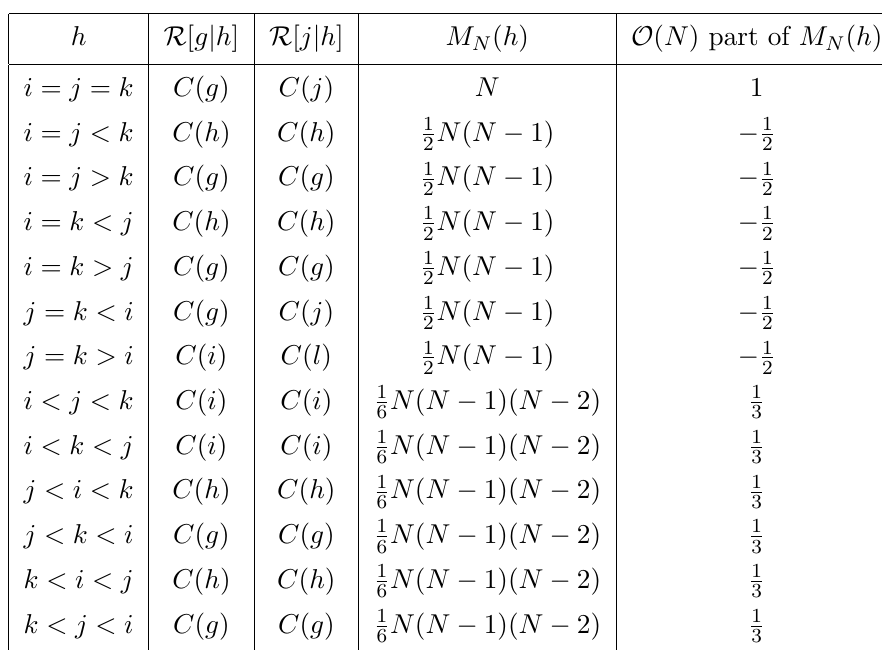
Table 1 . Replica analysis of the (2,4) web of figure